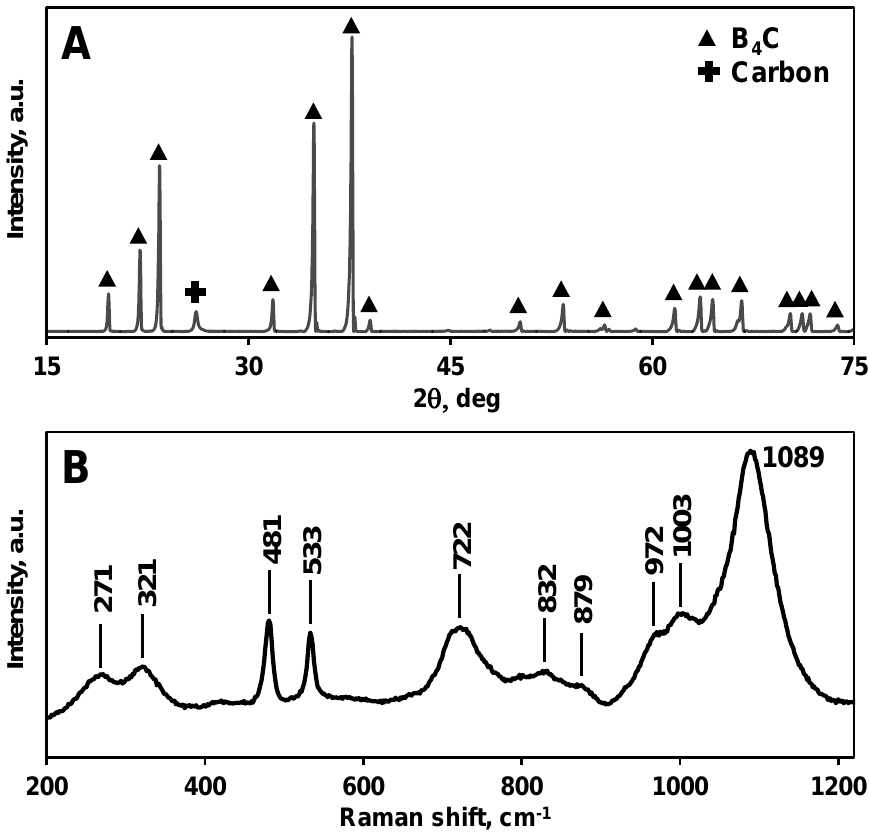
Figure 2. ( A ) X-ray di ff raction pattern and ( B ) Raman spectrum of B 4 C taken from polished surface.